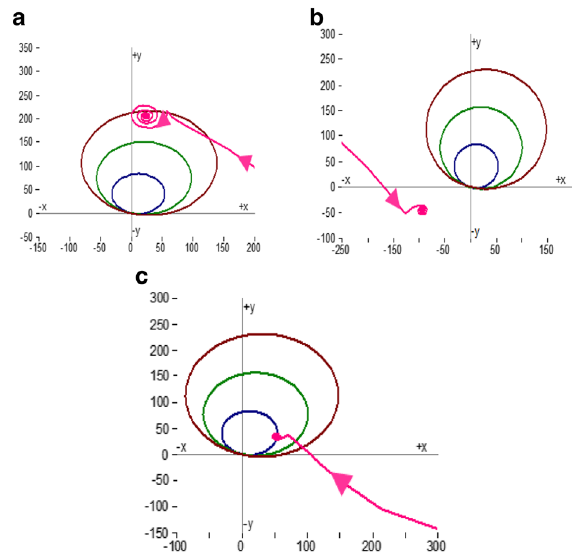
Fig. 4 Performance of ( a ) R 12 , ( b ) R 21 & ( c ) R 23 for LLG (RYG) fault at 500 km from Bus-1 (i.e. 150 km from Bus-2)